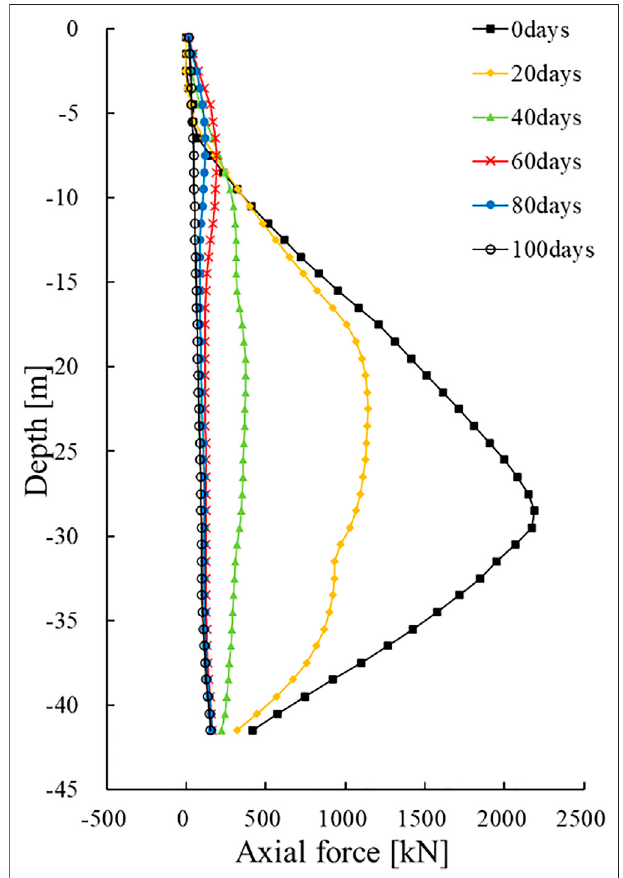
FIGURE 6 | Distribution of axial forces on PHC pile determined under various heights of back fi lls.